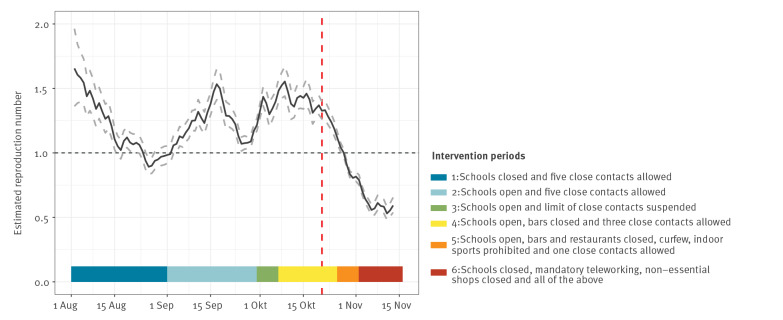
Estimated instantaneous reproduction number Rt based on daily reported cases and a mean 5.2-day serial interval (95% credible interval: 4.4–6.0 [14]), Brussels region, Belgium, 1 August–12 November 2020 (n = 63,838)